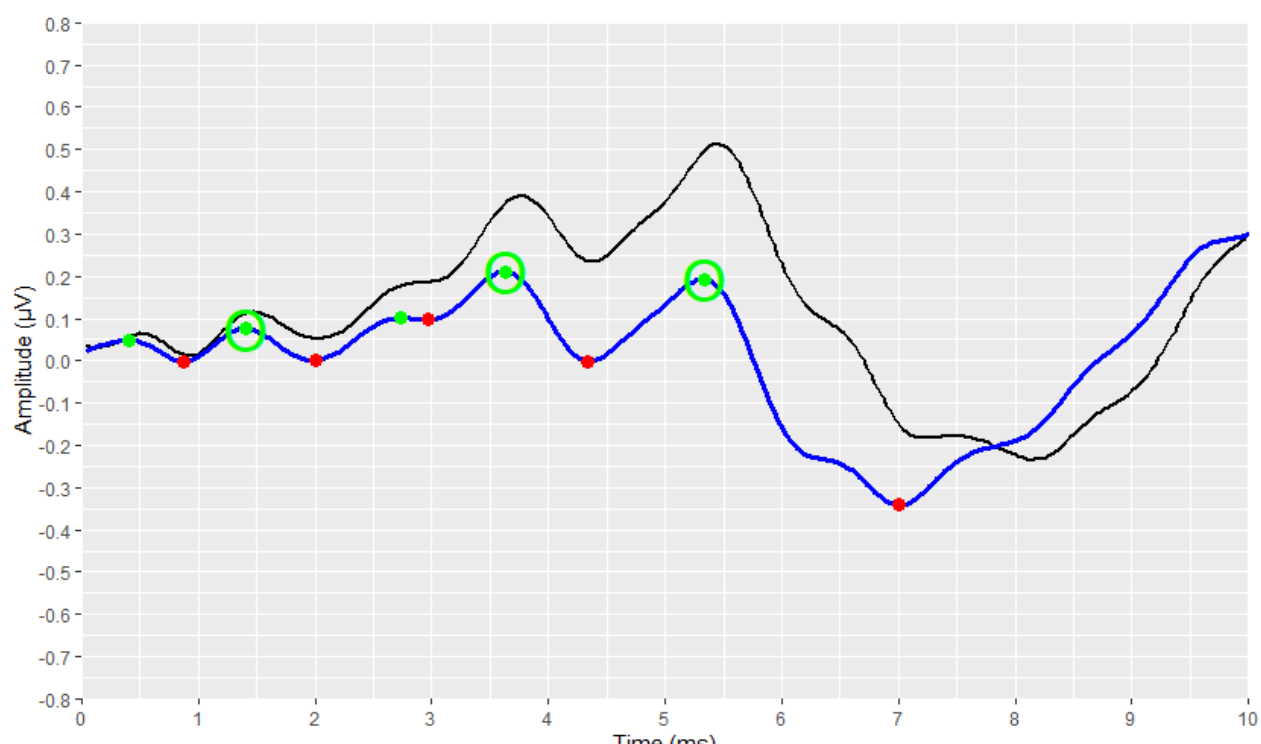
Figure 9. Detection of the AMLR signal’s waves of interest as resulting from the implementation of the AMLR automated annotation tool.